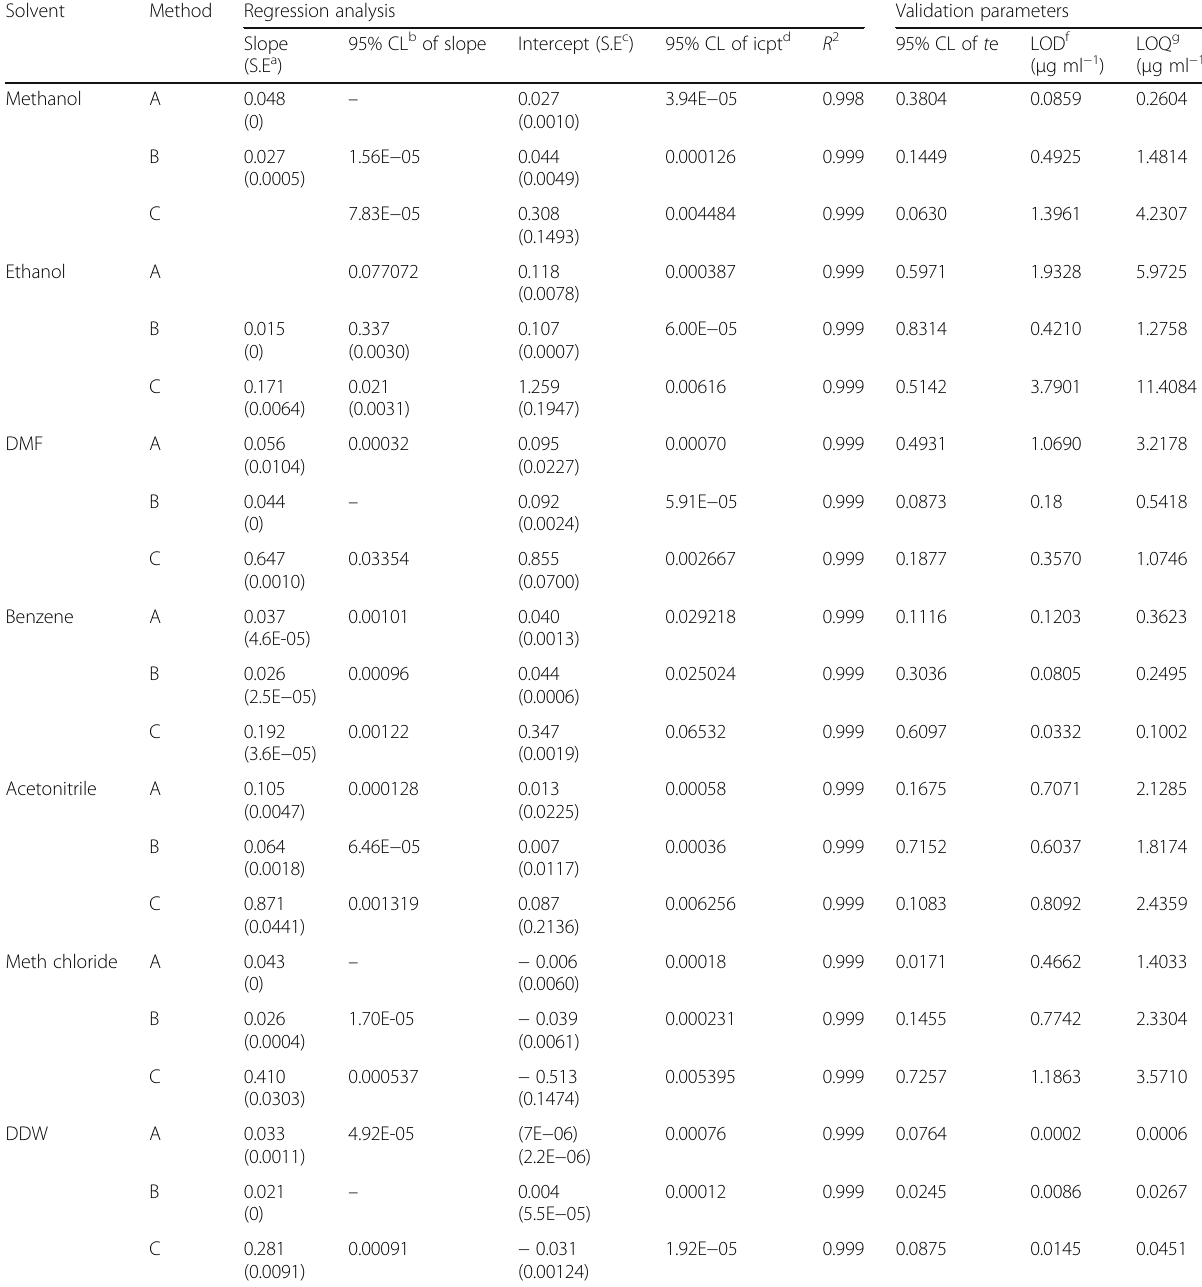
Table 2 Validation parameters and statistical data with regression analysis of satranidazole (STZ) ( n =